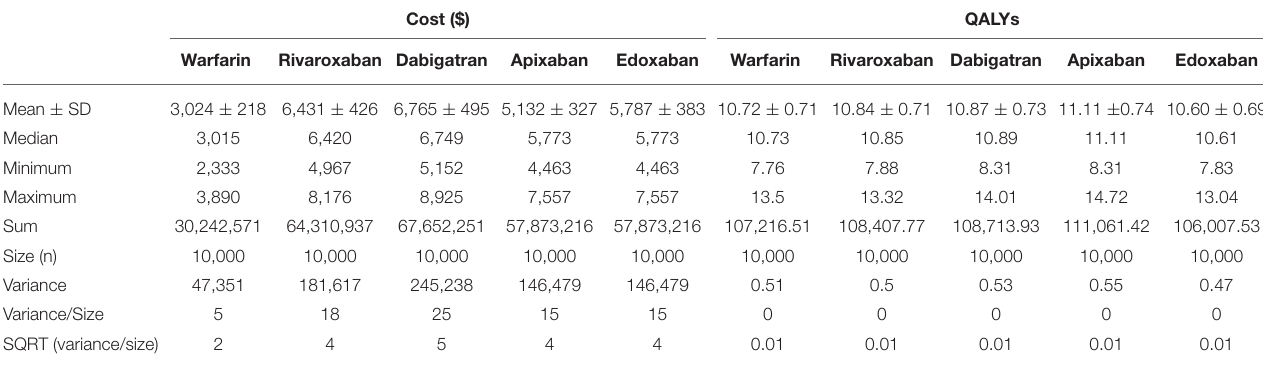
TABLE 6 | The PSA result of DOACs and warfarin.